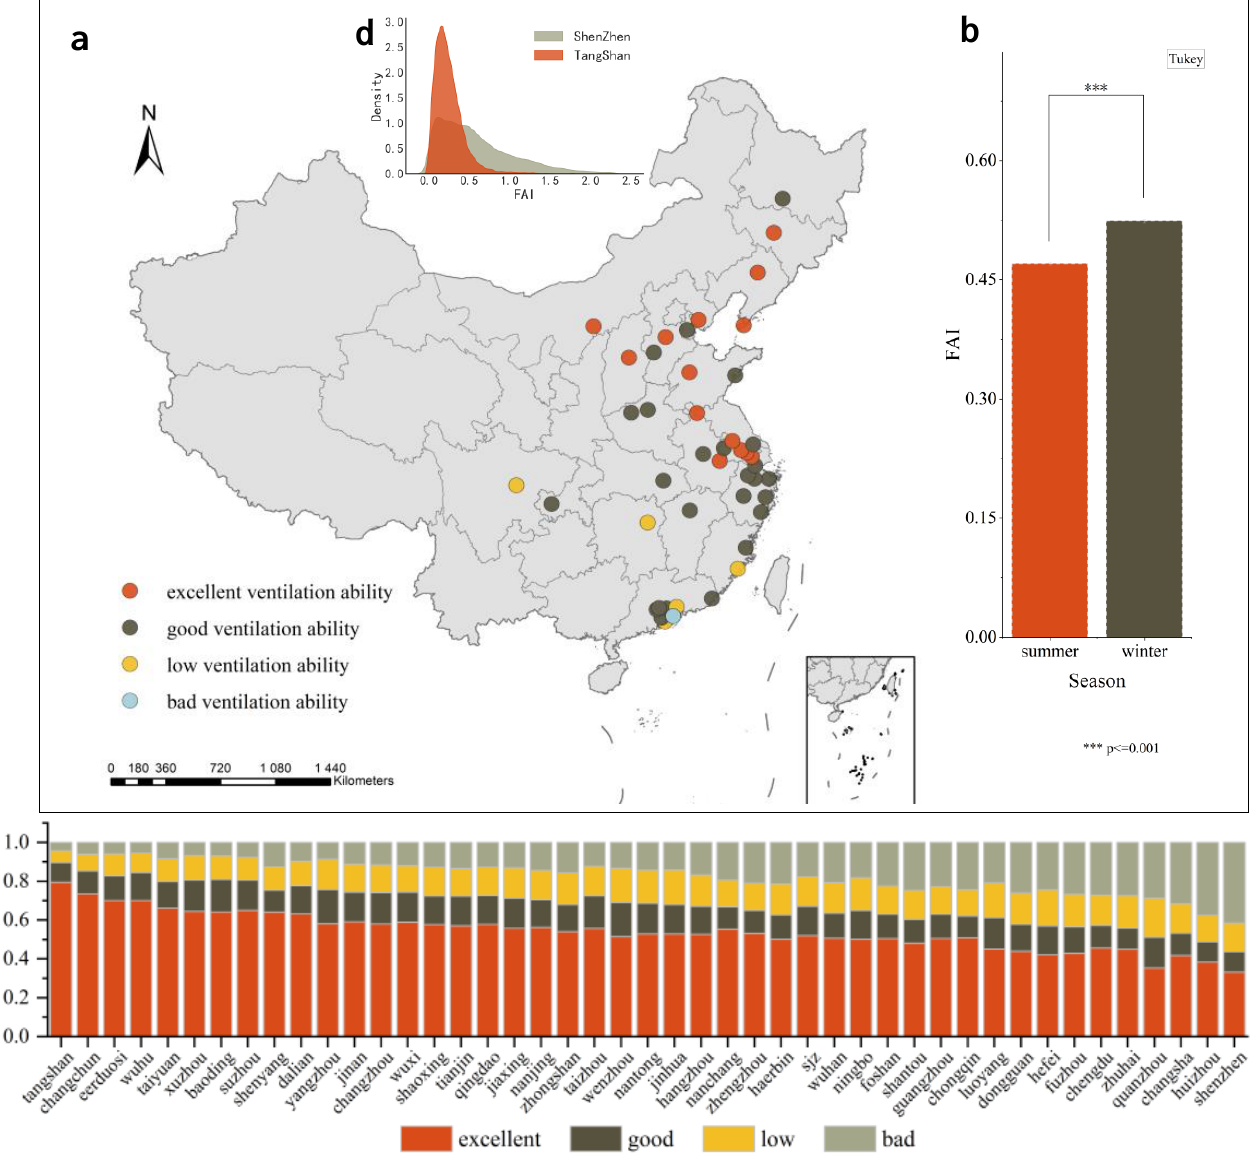
Figure 4. Ventilation capacities of 45 industrial cities: ( a ) the spatial distribution of ventilation capacities in 45 cities; ( b ) comparison of urban FAI in winter and summer; ( c ) the proportion of different levels of the ventilation capacity in each city; ( d ) density plots of FAI in Shenzhen and